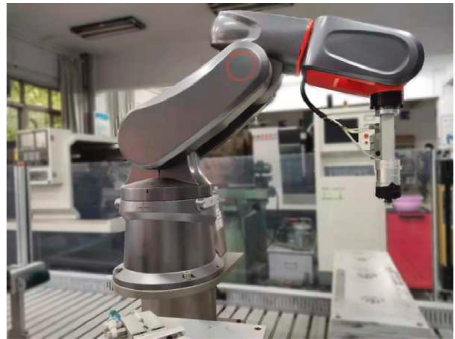
Figure 8: Industrial robot experiment bench.